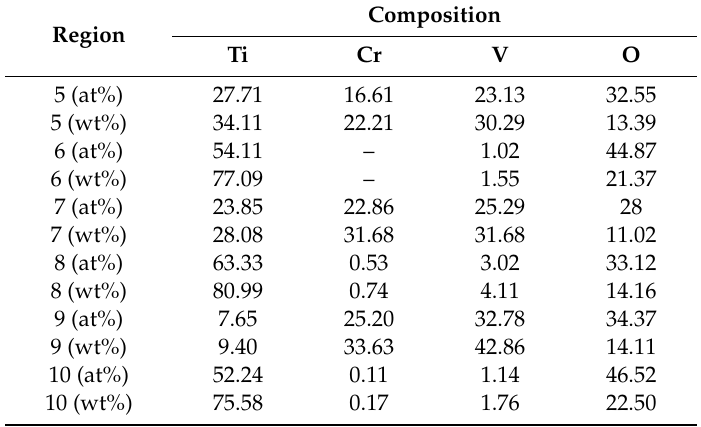
Table 2. Chemical compositions of di ff erent areas in oxide and melting zone in each test alloy.